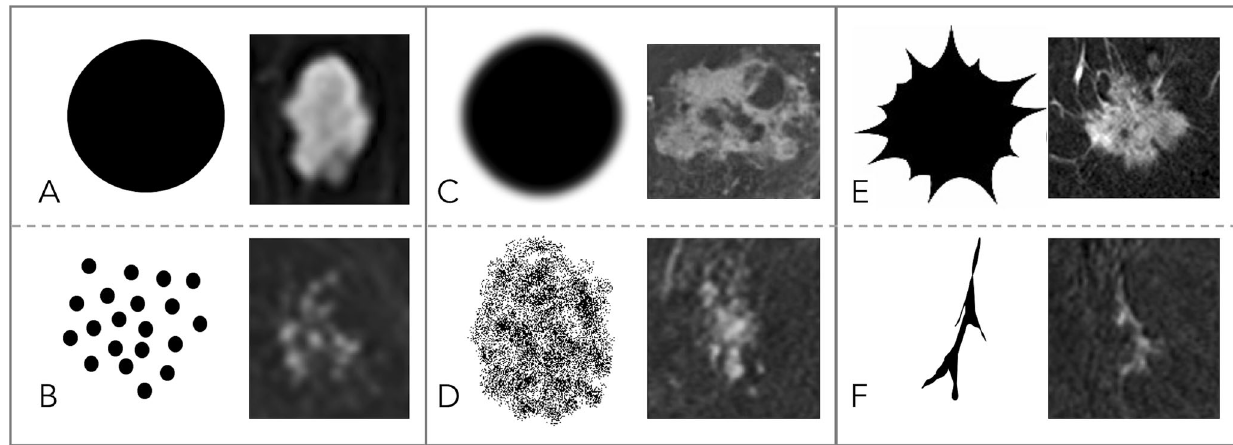
Fig. 3 Diagnostic criteria: margins. Margins can be either circumscribed or not circumscribed. Circumscribed margins indicate a benign lesion and are more regularly found in mass (A) than in non-mass (B) lesions. Non- circumscribed margins include irregular (C: mass lesion, D: non-mass lesion), hinting at an intermediate risk of breast cancer, and spiculated.